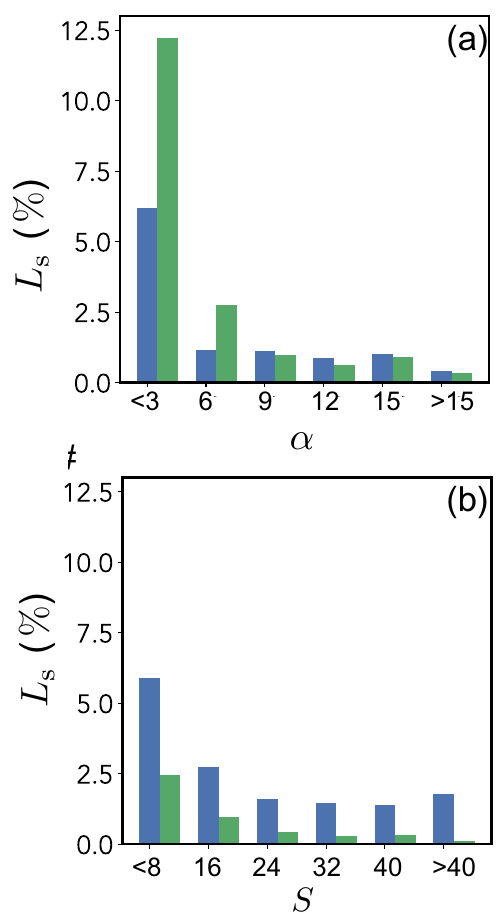
Figure 4. L s as computed from the tenfold cross-validation from the L w -model (green) and L M -model (blue) performance. ( a ) Shows the effect of α . ( b ) Shows the effect of S . A lower L s value means the model prediction is better in that range of